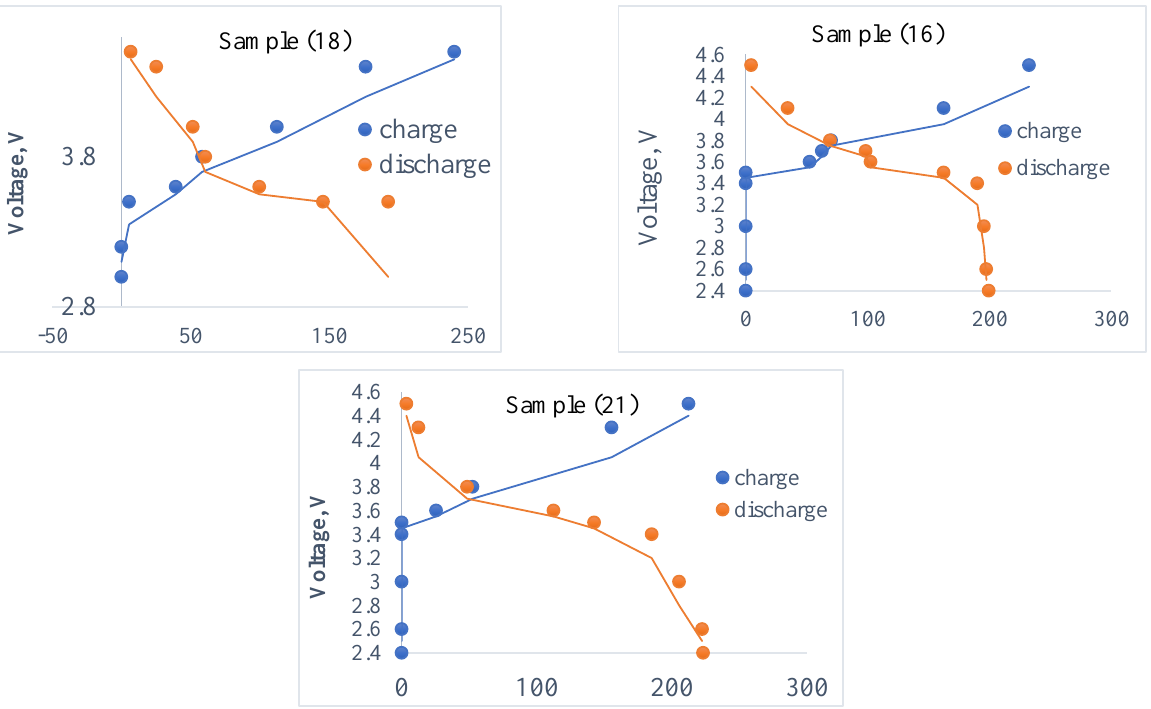
Figure 9. Charge and discharge capacities of samples 16, 18 and 21, which indicate that the best sample is (a). Due to the optimized synthesis conditions, the repeated sample exhibits better charge and discharge capacities (150, mAhg −1 discharge capacity) than the original sample.